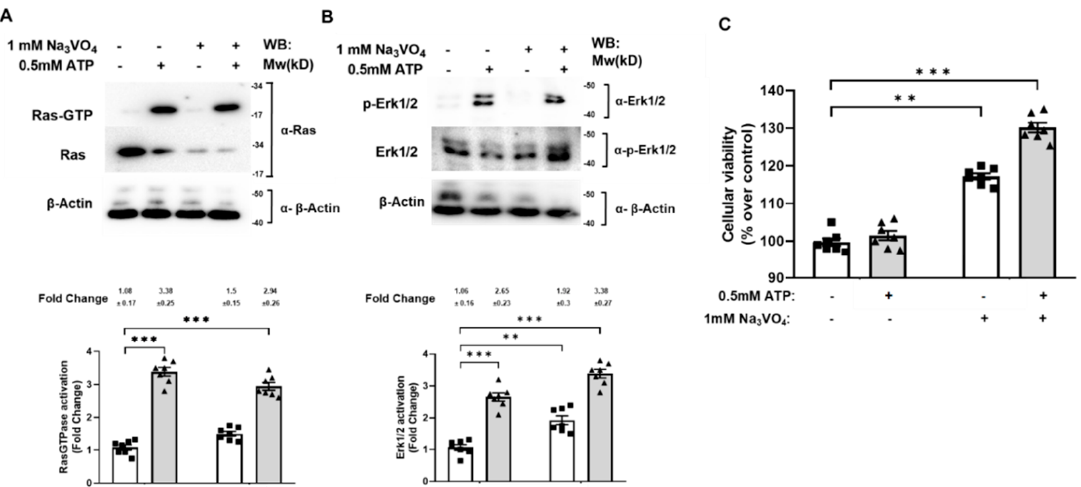
Figure 4. The tyrosine phosphatases mediate Ras/Erk1/2 activation and control SN4741 cells viability. SN4741 cells were serum-starved overnight, and cells were previously treated, or not, with 1 mM Na 3 VO 4 for 20 min and subsequently stimulated, or not, with 0.5 mM ATP for 5 min and lysed. Cell lysates were used to measure ( A ) Ras activation by the affinity precipitation assay and ( B ) ERK1/2 phosphorylation in total extracts. The precipitated active Ras (Ras-GTP), p44/42 phosphorylation, total Ras, Erk ½, and β -Actin expression levels were analyzed by Western blotting using specific antibodies. Immunoblots are representative of four independent experiments. Each histogram bar includes the values of four different samples. All values are expressed in fold change. The differences between treatments were p < 0.001 in all cases (***) (Mann–Whitney test). ( C ) SN4741 cells were serum-starved overnight and were treated, or not, with 1 mM Na 3 VO 4 for 20 min and subsequently stimulated, or not, with 0.5 mM ATP for 5 min, and cellular viability was measured by the MTT assay. All values are represented as the percentage over control (untreated) cells and show the mean of seven independent experiments ± SEM. Statistical analysis shows a significant difference (** p < 0.01 and *** p < 0.001).